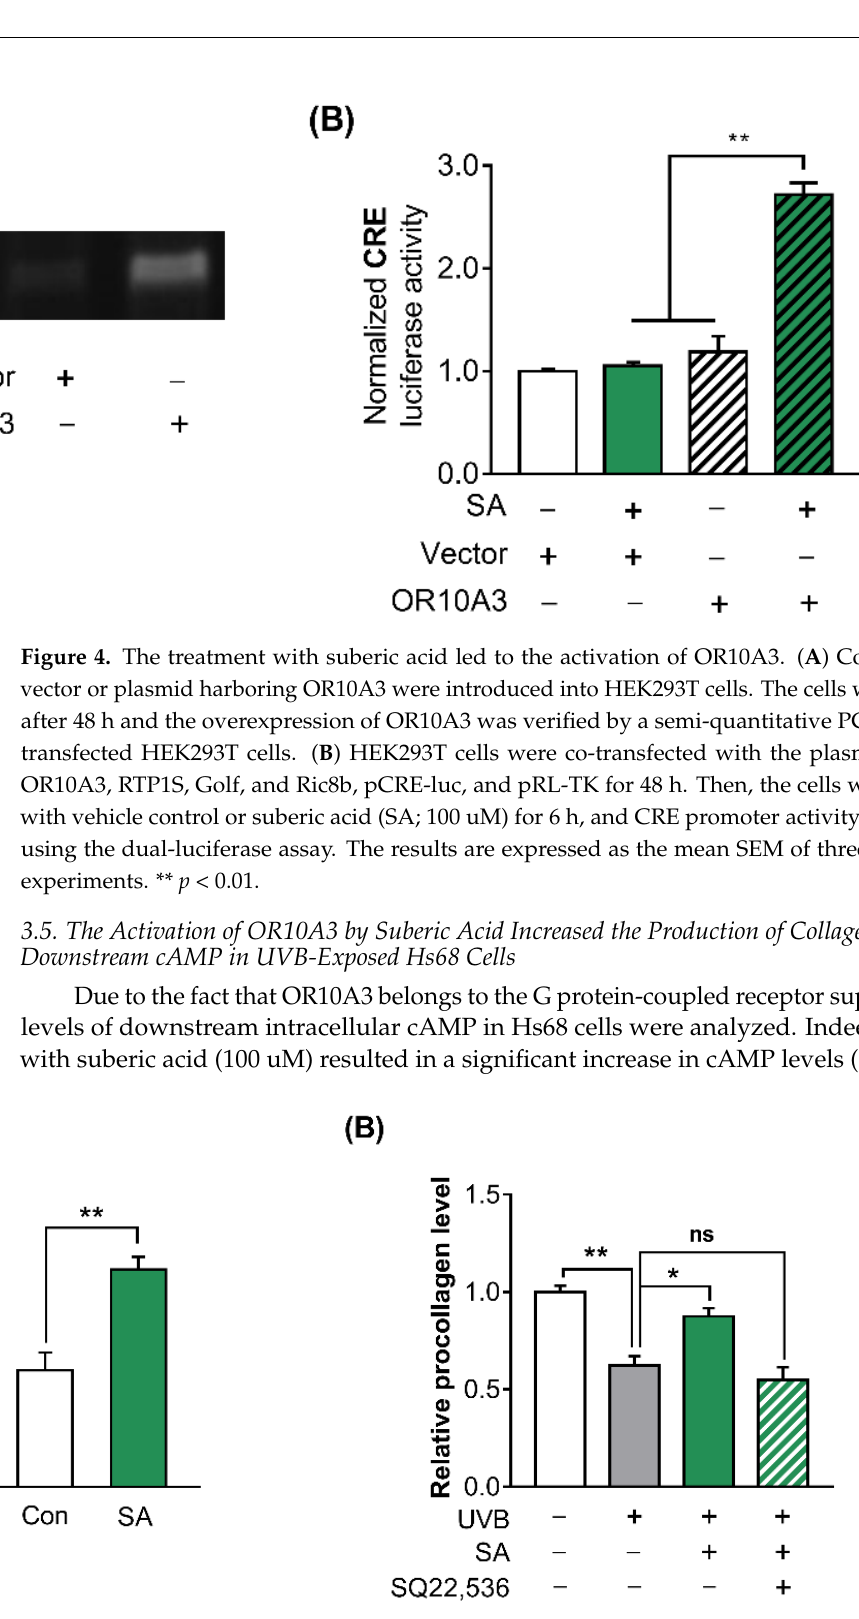
Figure 5. The activation of OR10A3 by suberic acid increased the production of collagen via downstream cAMP in UVB-exposed Hs68 cells. ( A ) The cells were treated with suberic acid (SA; 100 uM) or the vehicle and then intracellular cAMP levels were analyzed. ( B ) Procollagens concentrations in the supernatant of UVB-exposed Hs68 cells treated with suberic acid (100 uM) and SQ22,536 (50 uM) for 24 h. Results are shown as means ± SEM ( n = 3). Significant differences between groups are shown as * p < 0.05; ** p < 0.01; ns, not significant.